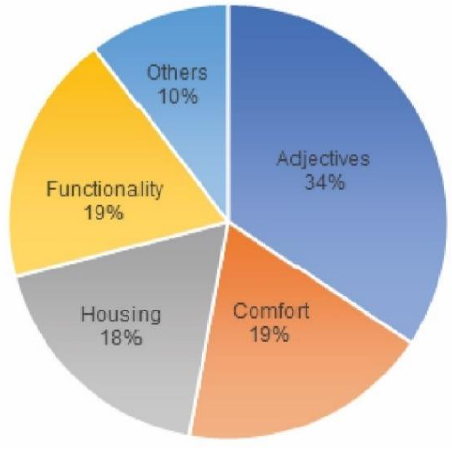
Figure 7. Highlights by respondents.